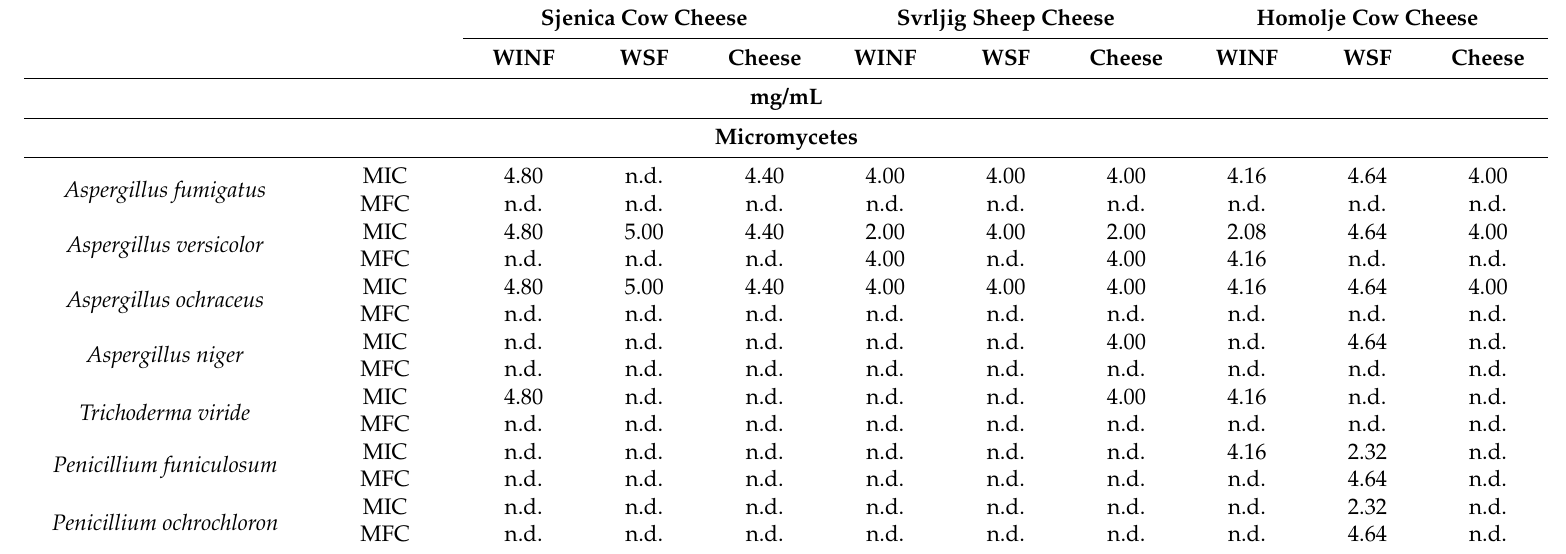
Table 4. The antifungal activity of cheese digestates and their fractions